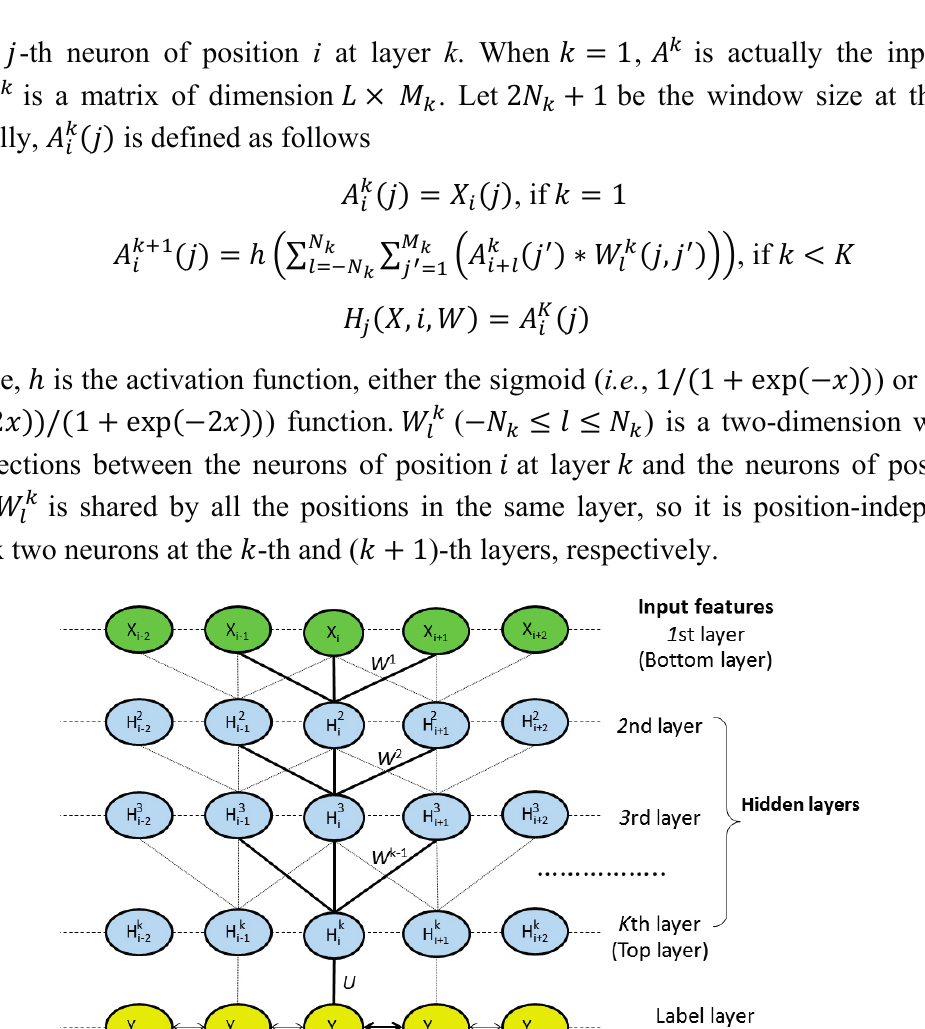
Figure 1. The architecture of DeepCNF, where (cid:1861) is the residue index, (cid:1850)